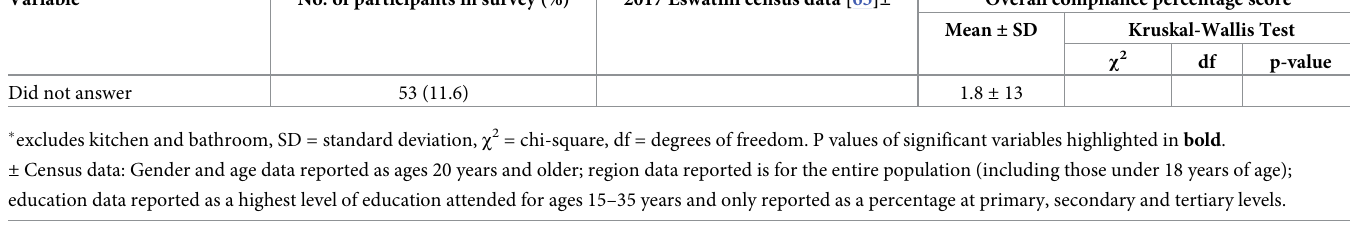
not travel to their village homestead, did not have one or lived there, compared with 54% of males (S1B–S1E Fig). There was no significant difference (p > 0.05) between males and females for compliance in the type of activities carried out whilst away from home (e.g., essential activi- ties such as work, shopping, seeking medical treatment), Fig 1. A total of 129 essential workers responded to the survey, representing 13 areas of employ- ment (S2C–S2G Fig). There was a significant positive association between being an essential worker and overall level of compliance to prevention measures according to the chi-square test of independence ( χ 2 = 21.287, d.f. = 3, p < 0.01), with a weak effect size (Cramer’s V = 0.18). It is interesting to note, average overall compliance to public health and social measures was